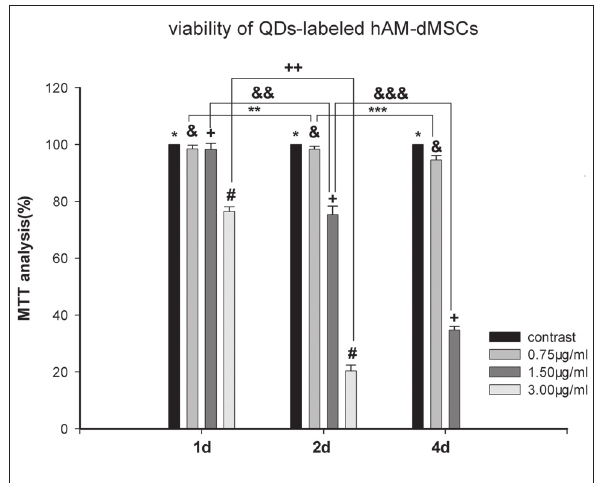
Fig. 4. QDs affect viability of hAM-dMSCs. In MTT assay, hAM-dMSCs were culturing in different conversation of QDs suspension under 1, 2 and 4d. The data are presented as the mean ± standard error (S.E.). 1d, * P > 0.05 & , & P > 0.05#, # P < 0.05+; 2d, * P > 0.05 & , & P < 0.05# , # P < 0.05+; 4d, * P < 0.05&, & P <0.05#; ** P > 0.05; *** P < 0.05; P <0.05; P < 0.05; ++ P < 0.05(n=8)